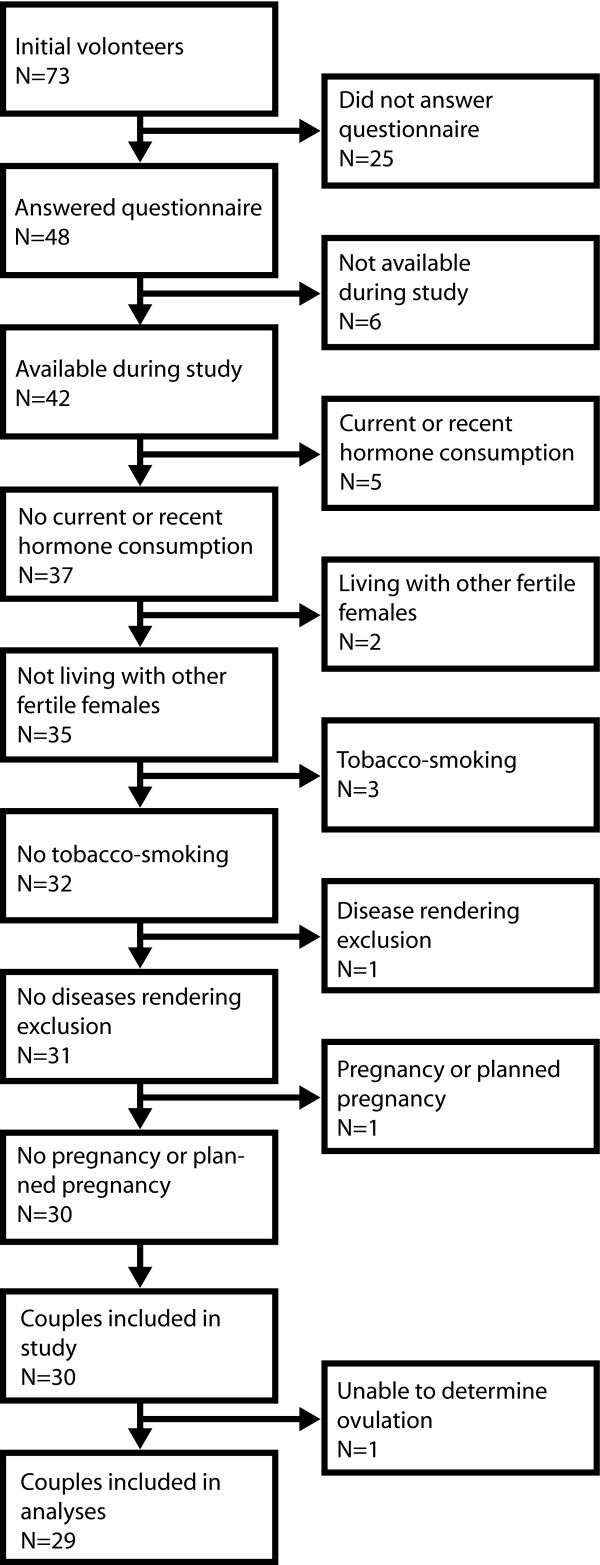
Inclusion/exclusion flow chart. Flow chart of the number of initially volunteering couples and the inclusion/exclusion process. Out of the 48 couples that answered the questionnaire, 30 were finally included in the study. One couple were excluded after data collection because of difficulties in determining the ovulation date, leaving 29 couples to be included in the analyses.